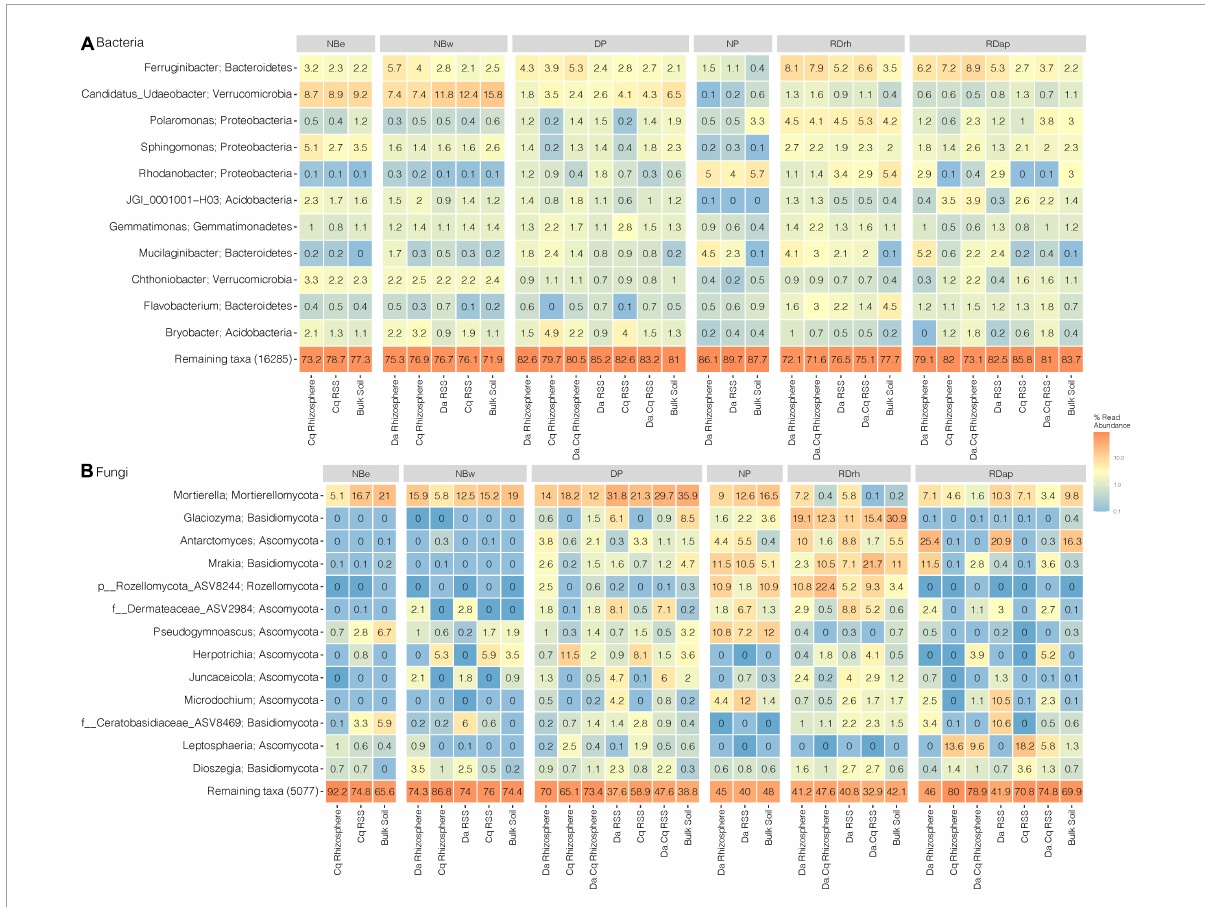
FIGURE5 Microbial community composition for bacteria (A) and fungi (B) in Deschampsia antarctica (Da), Colobanthus quitensis (Cq), and their association (DaCq). We took only the most abundant taxa (abundance ≥ 1% in the total samples) at their genus or best-hit taxonomic classification by sampling site and plant species compartment. Heatmap colors represent the taxa relative abundance (arithmetic mean by plant compartment) on a logarithmic scale.